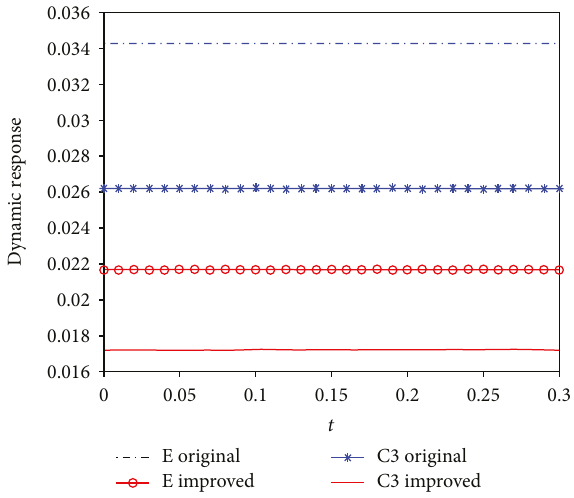
Figure 5: Dynamic response optimization comparison regarding tooth de fl ection.